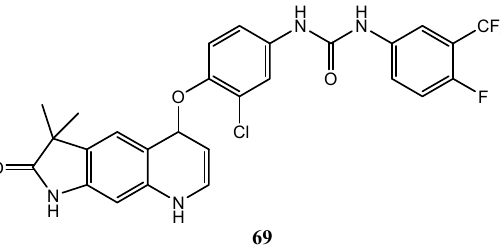
Figure 37. 3,3-dimethyl-1 H -pyrrolo[3,2- g ]quinolin-2(3 H )-one derivative as potent C-Raf inhibitor [143].